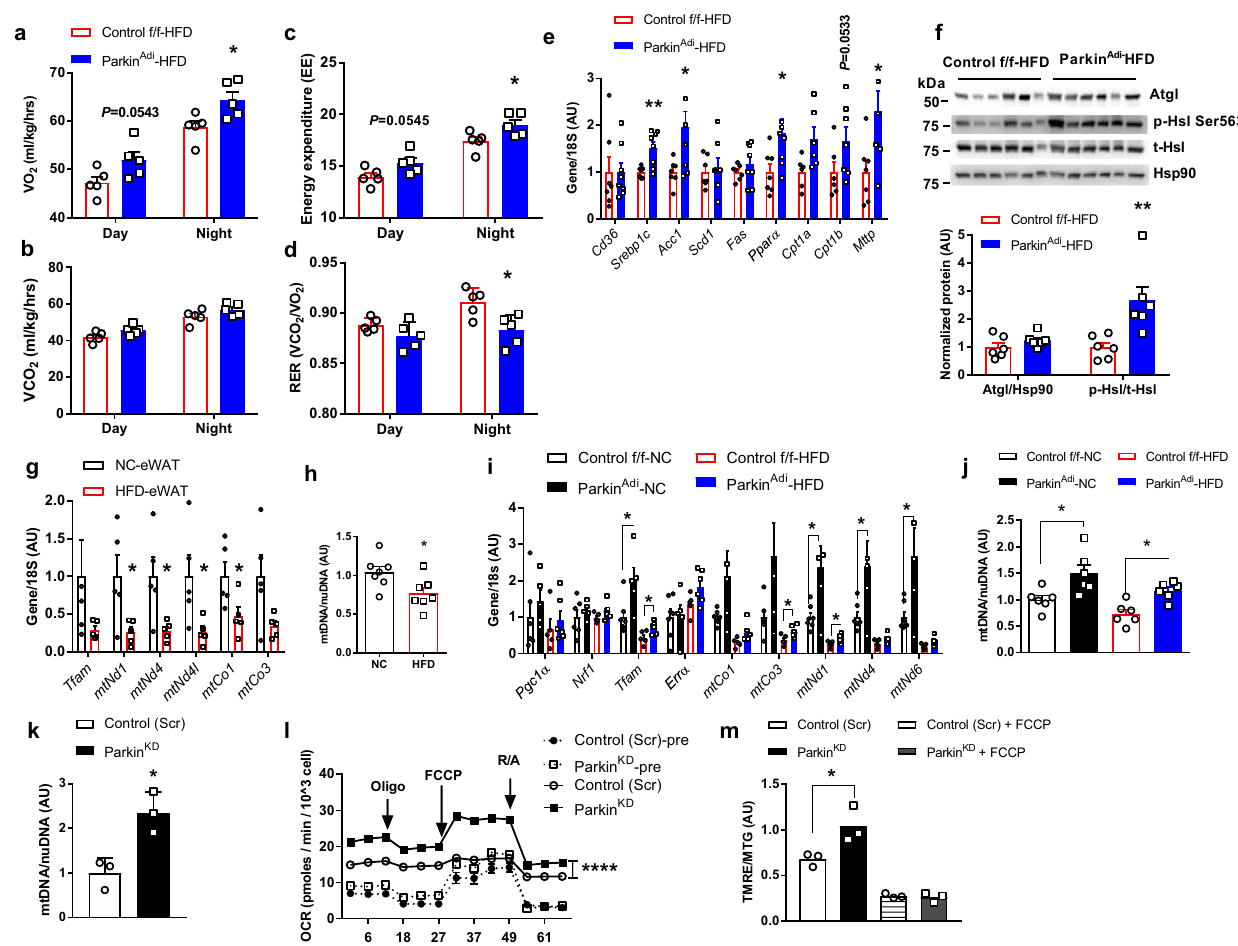
Fig.3|Parkindeletionelevatesenergyexpenditureandmitochondrialactivity in adipocytes. a Oxygen consumption [Unpaired Student ’ s t test two-tailed.